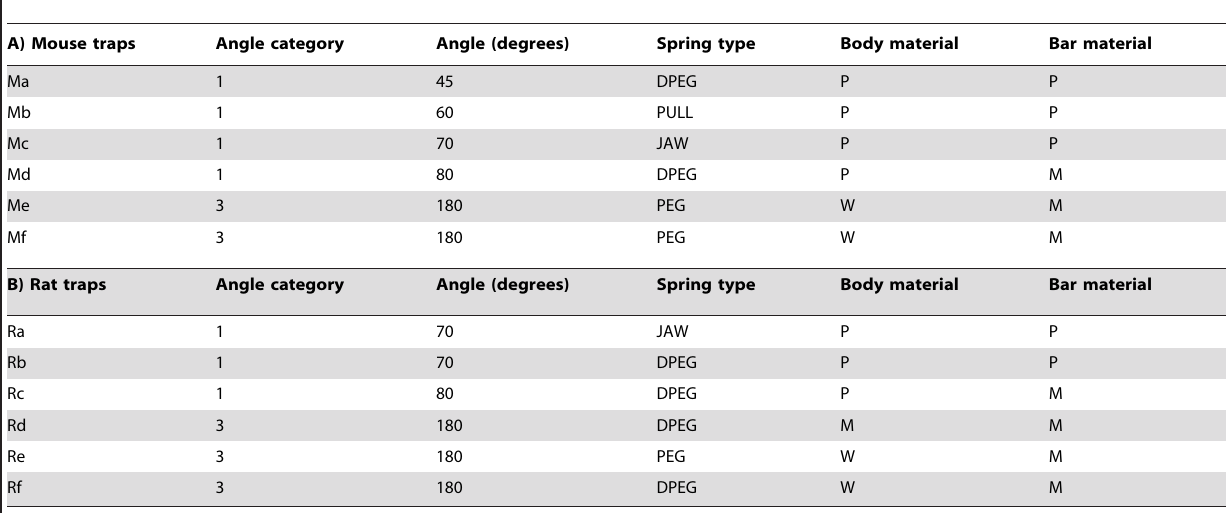
Table 1. Mouse and rat traps selected for the replicated set, and their features. A) mouse traps; B) rat traps.